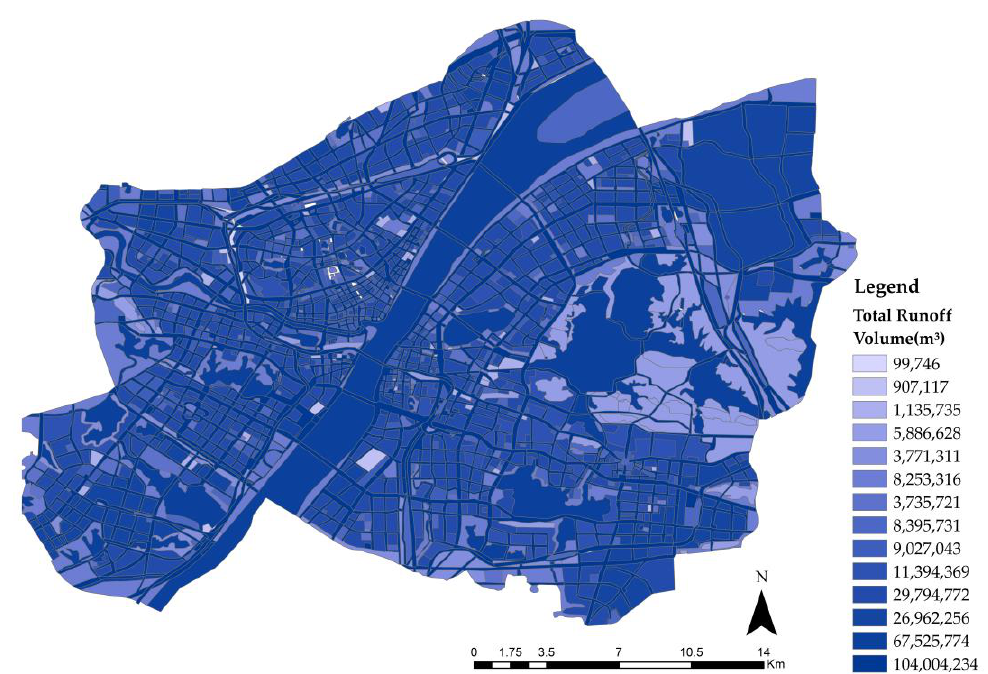
Figure 4. Spatial distribution of total runoff